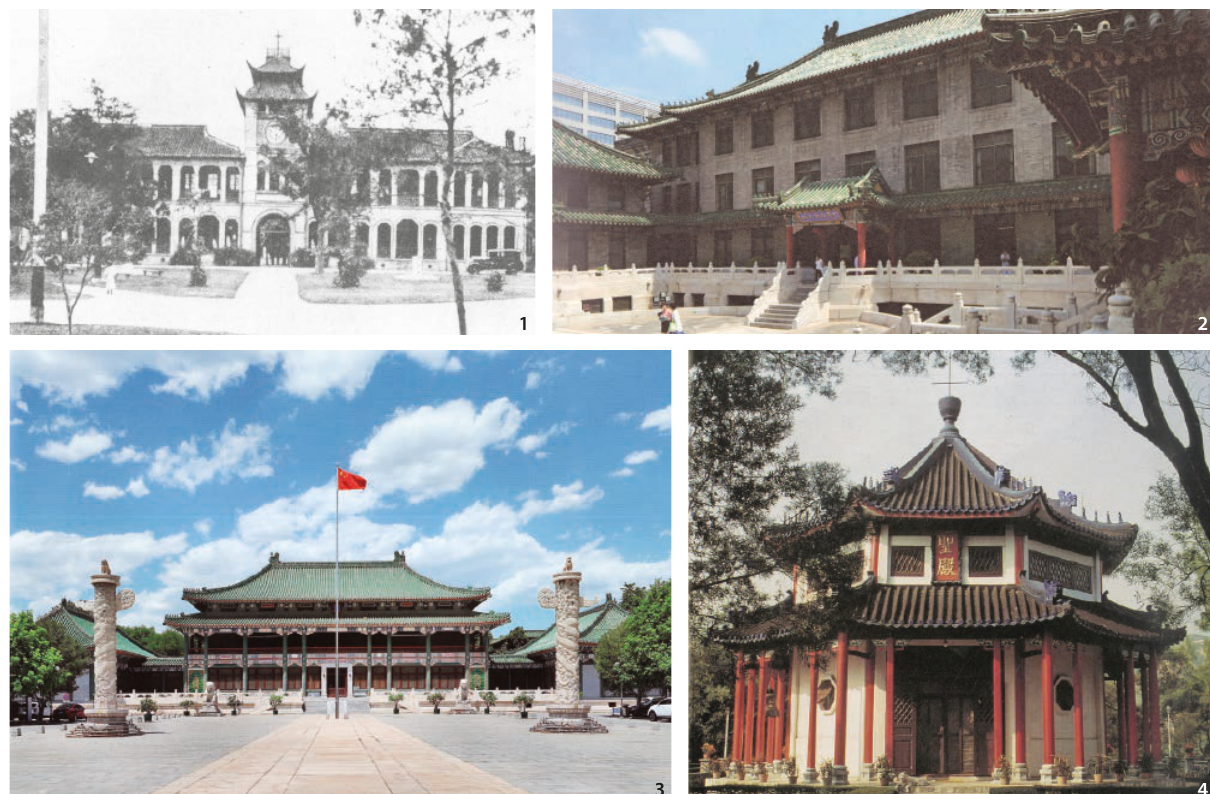
2 1 3 Figure 1 The Schereschewsky Hall of Shanghai St. John’s University, 1895, with its façade featured as a wester style verandah capped with a Chinese overhanging roof (Source: Chen 1988, 107). Figure 2 Peking Union Hospital, designed by the Canadian architect Harry Hussey and the American architect Conrad W. Anner, 1921 (Source: CRC, ASC, and CSCR-C20C 2016, 173). Figure 3 Beiping Library, designed by the American architect Henry K. Murphy, 1931 (Source: BIAD and CSCRC20C 2019, 165). Figure 4 Tao Fung Shan Monastery Buildings in Sha Tin District, New Territories, Hong Kong (Source: Yingchun Li).